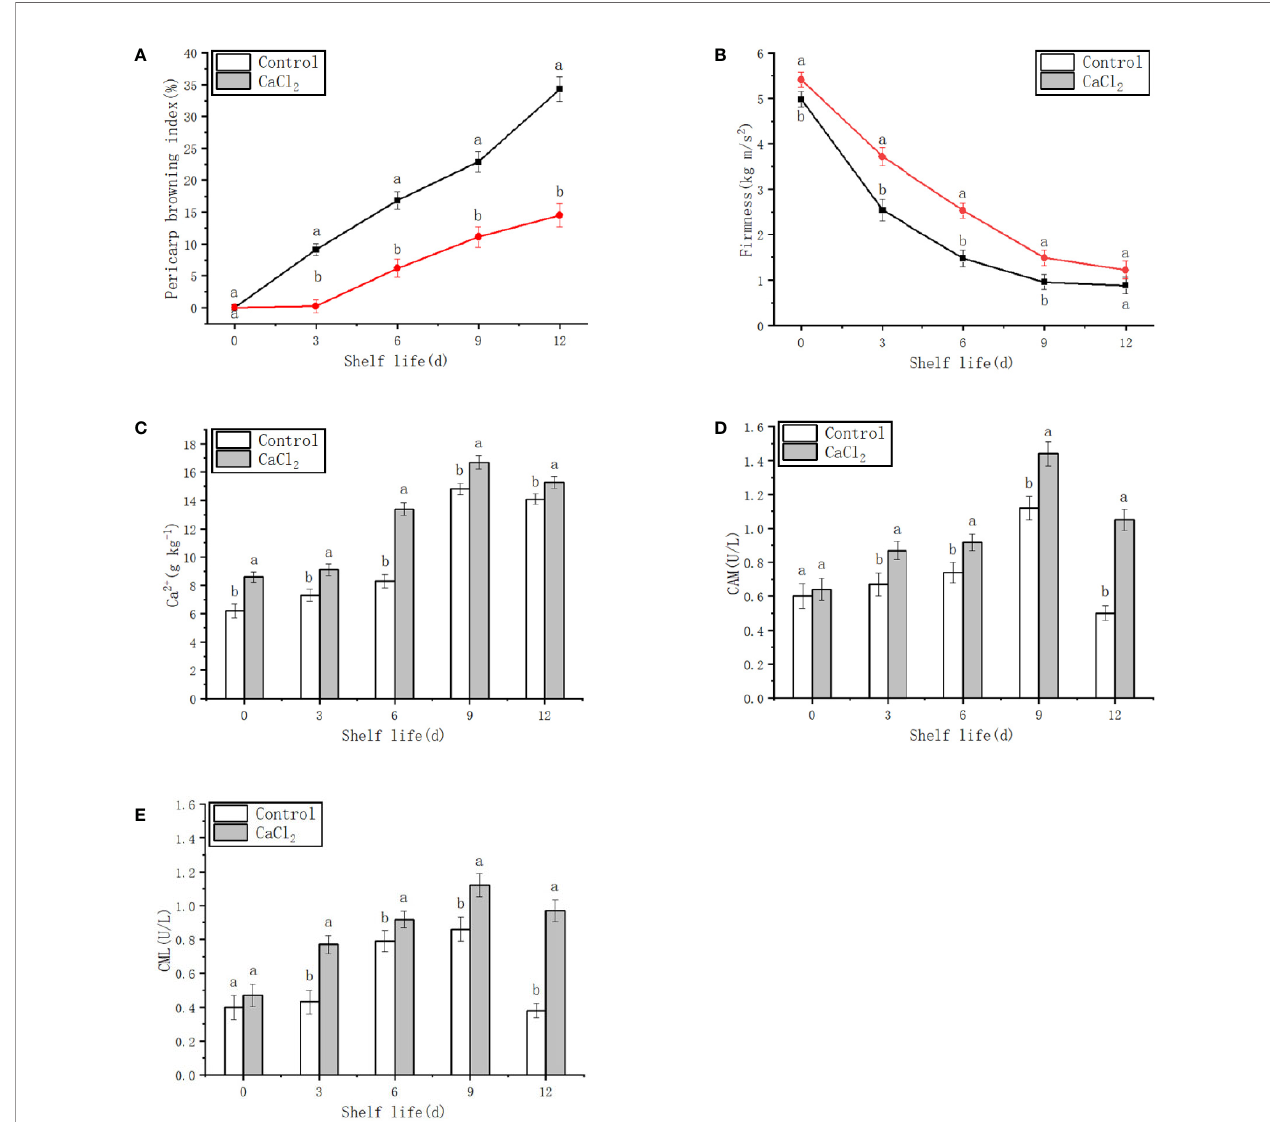
FIGURE 2 | Pericarp browning index (A) , fi rmness (B) , Ca 2+ (C) , CaM content (D) and CML content (E) in ‘ Nanguo ’ pear fruit during the 0, 3, 6, 9, and 12 days at 20°C after cold storage. Means ± SE of three replicate experiments are shown. Means with different letters are signi fi cantly different between the treatments and control ( p <